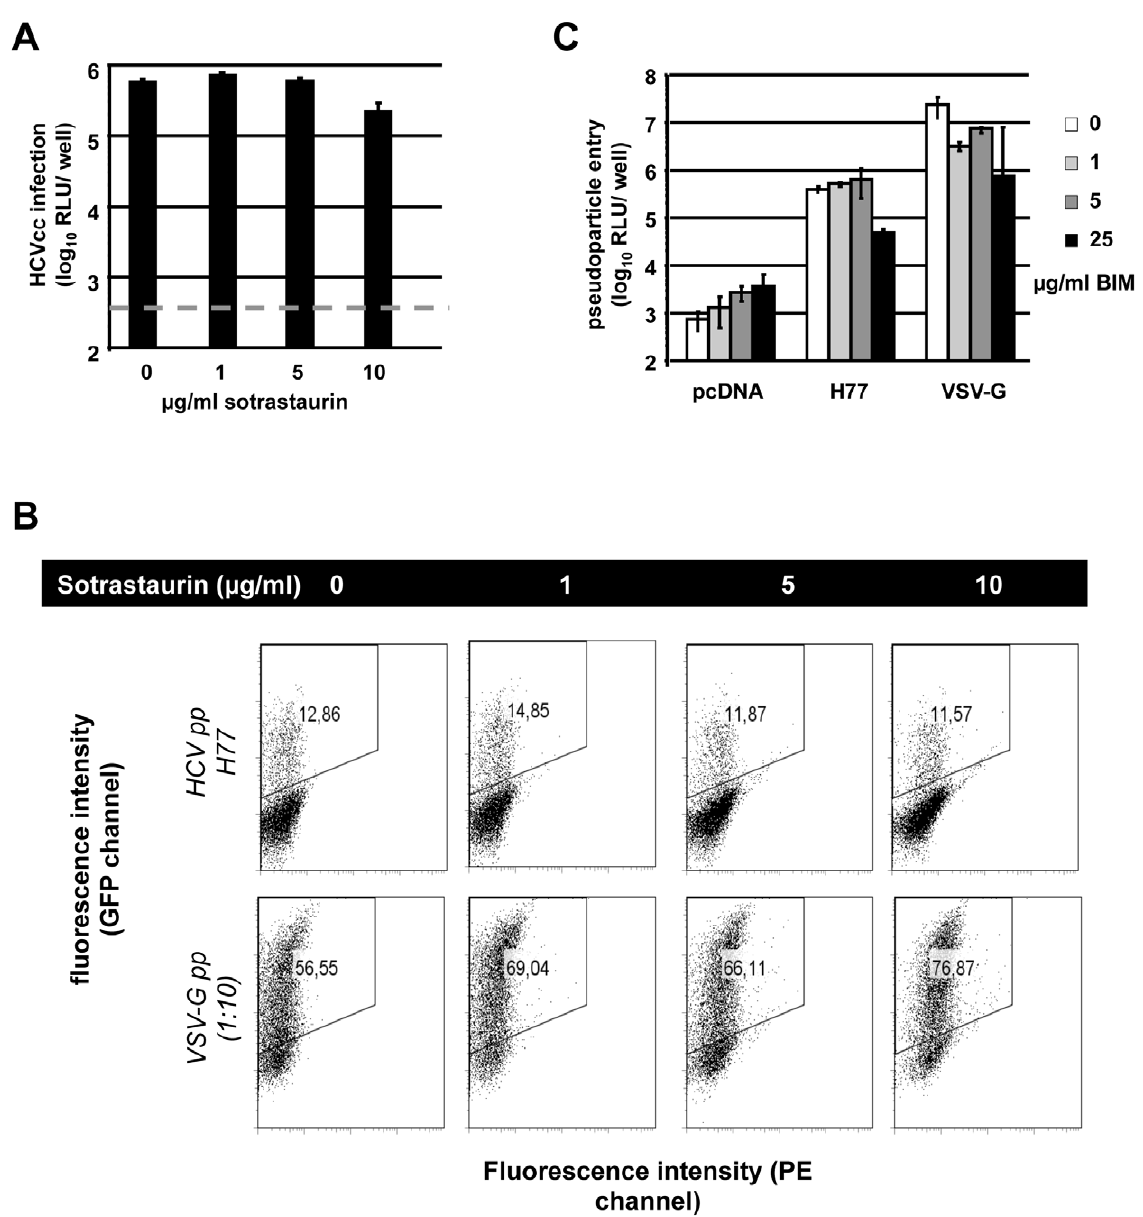
Figure 2: Effect on early HCV replication cycle stages. (A) Infection of Huh-7.5 cells with Jc1-Luc produced in the absence of sotrastaurin. The drug was added for at least 4 h during infection. (B) Strain H77 HCVpp infection of Huh-7.5 cells in the presence or absence of sotrastaurin. Pseudoparticles bearing the glycoprotein of the vesicular stomatitis virus (VSVG) served as controls. (C) Pseudoparticle infection of Huh-7.5 cells in the presence of increasing concentrations of BIM-I. pcDNA represents pseudoparticles devoid of viral glycoproteins.